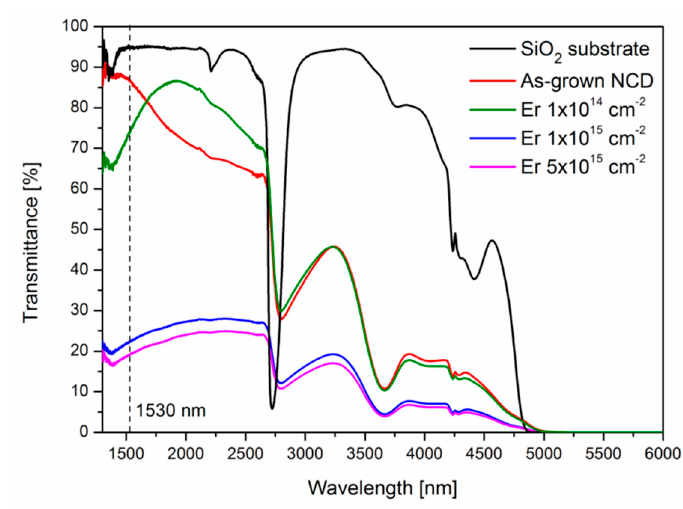
Figure 1. NIR transmittance spectra of the SiO 2 substrate, as-grown nano-crystalline (NCD) and the prepared samples (after Er ion implantation and annealing at 800 °C). All the transmittance percentage values are relative values according to the background.